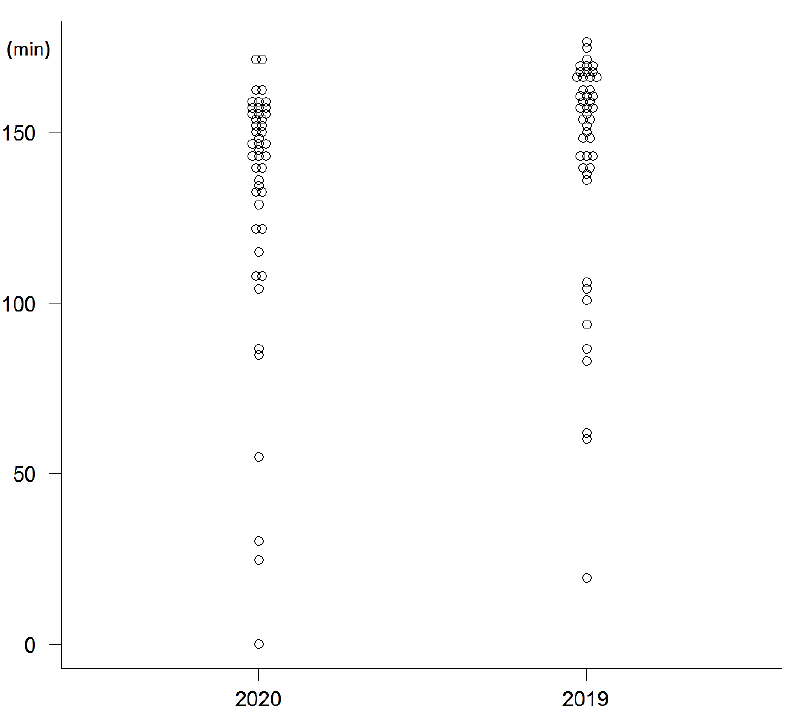
Figure 1. Training time of discharged patients. The distribution of training time of a discharged patient per day is shown. Statistical details are described in Table